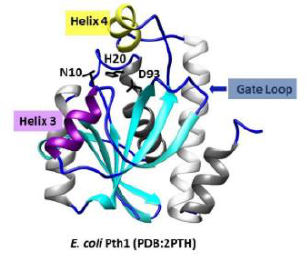
Figure 1. The crystal structure of E. coli Pth1 (PDBID: 2PTH). Labeled are the catalytic residues N10, H20, and D93, helix-3 in purple, helix-4 in yellow, and the gate loop. On the right is the amino acid sequence alignment.